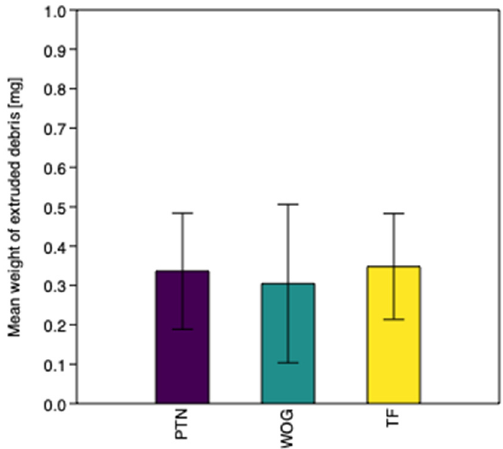
Figure 1. Mean weight of extruded debris for experimental groups.